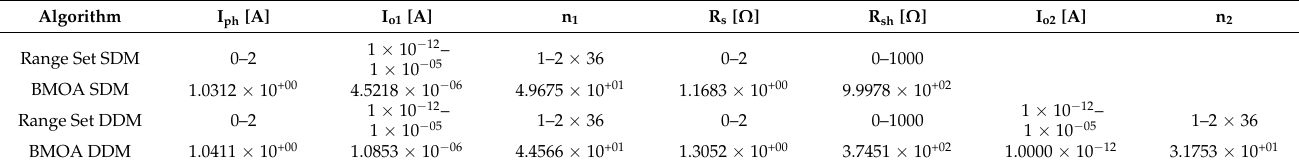
Table 12. PWP201 photovoltaic panel parameters and